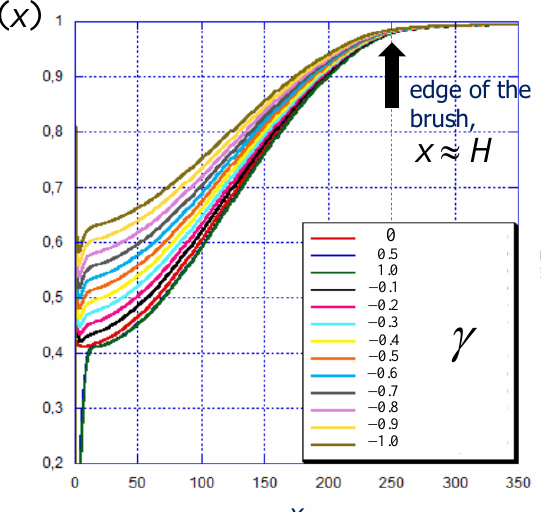
Figure 5. Profile of the degree of ionization in weak polyelectrolyte brushes as a function of distance x from the grafting surface at a varied value of the reduced surface charge γ . The pH − pK is set to adjust the average degree of ionization in the brush grafted to the neutral surface equal to (cid:104) α (cid:105) = 0.5. Other parameters: N = 300, a 2 / s = 0.001, salt concentration c s a 3 = 10 − 5